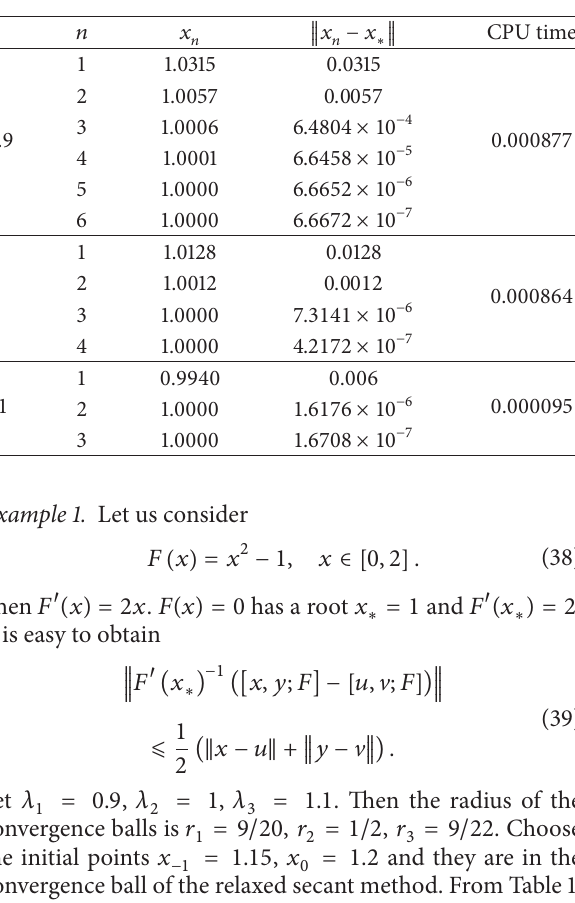
Table 1: Relaxed secant method with different 𝜆 . Table 2: Relaxed secant method with different 𝜆